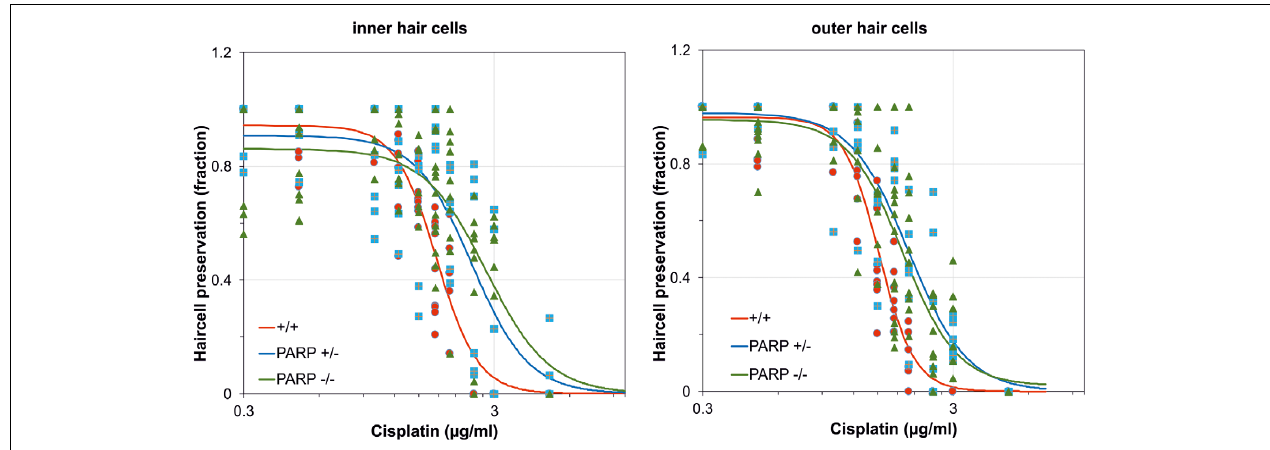
FIGURE 1 | Dose-response curves after cisplatin exposure calculated for the fraction of preserved inner and outer hair cells in wildtype (red; n = 3–9), heterozygous (blue; n = 5–6), and homozygous PARP-deficient (green; n = 4–13) mice (11 concentrations for each genotype). Regression lines were obtained using non-linear regression